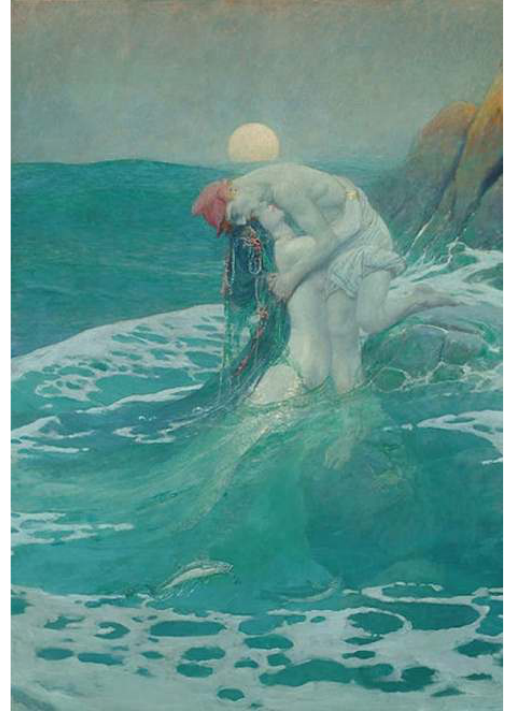
Figure 2. Howard Pyle, The Mermaid . Oil on canvas